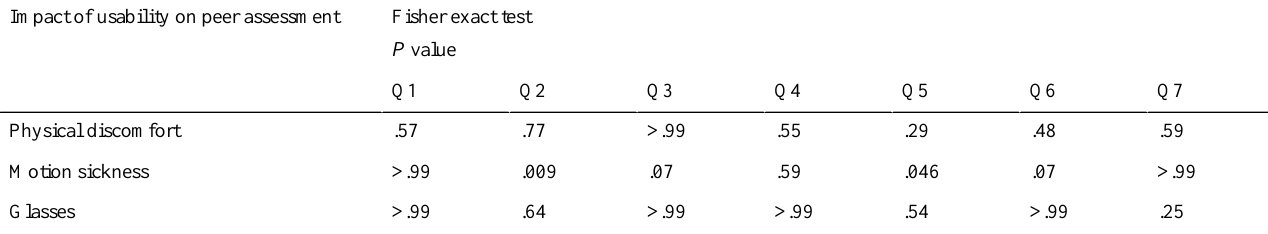
Table 9. Peer assessment scores using the full-immersive virtual reality display system between the groups with and without physical discomfort, motion sickness, and eyeglass